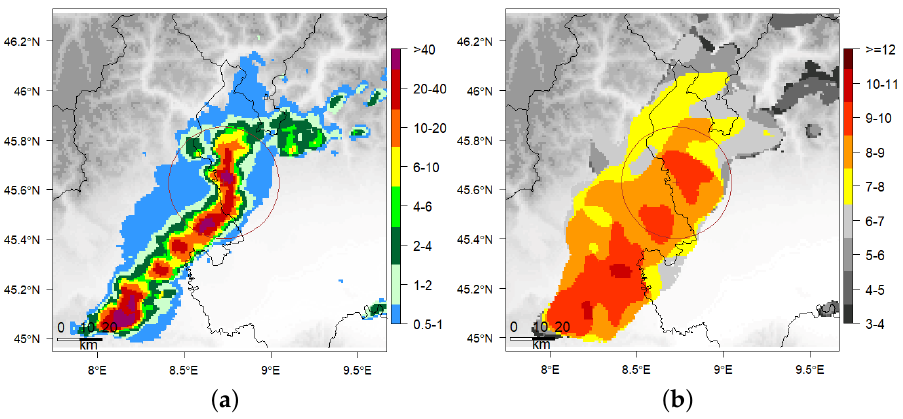
Figure 3. VIL (kg m − 2 , ( a )) and ETM (km, ( b )) radar products at 14:50 UTC when the squall line has affected the Malpensa airport, producing a large amount of hail on runways that caused the closure. The red circle is centered on the Malpensa airport and has a radius of 50